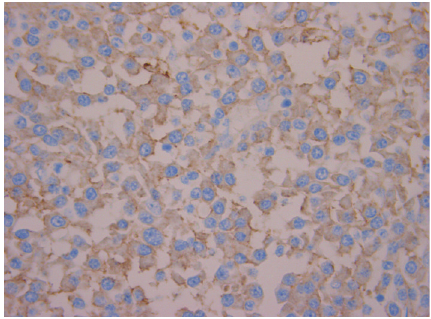
Figure 4: CD138 immunostain was positive, confirming plasma cells